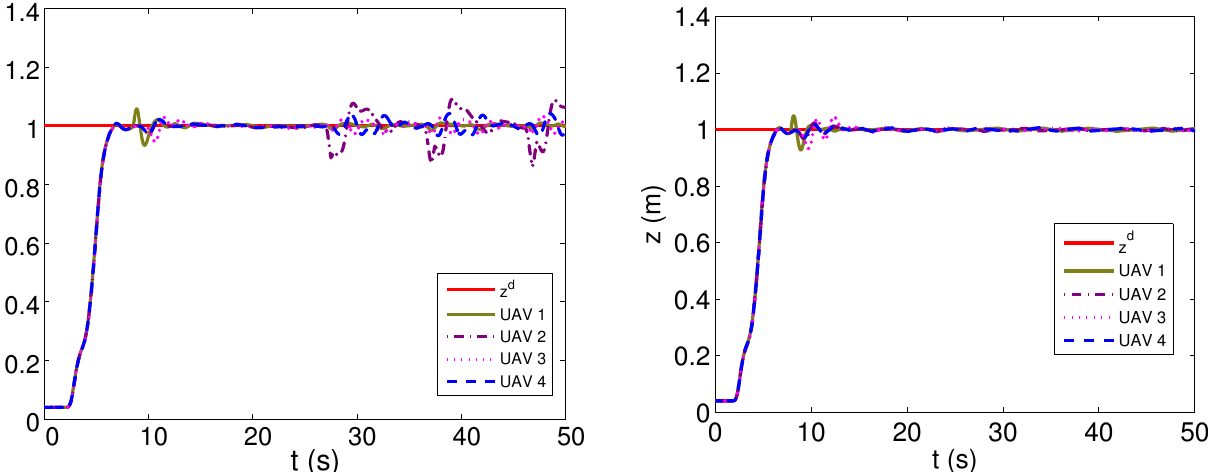
Figure 7. Altitudes of the quadrotors. Left : Formation control without high-order feedforwards. Right : Our proposed formation